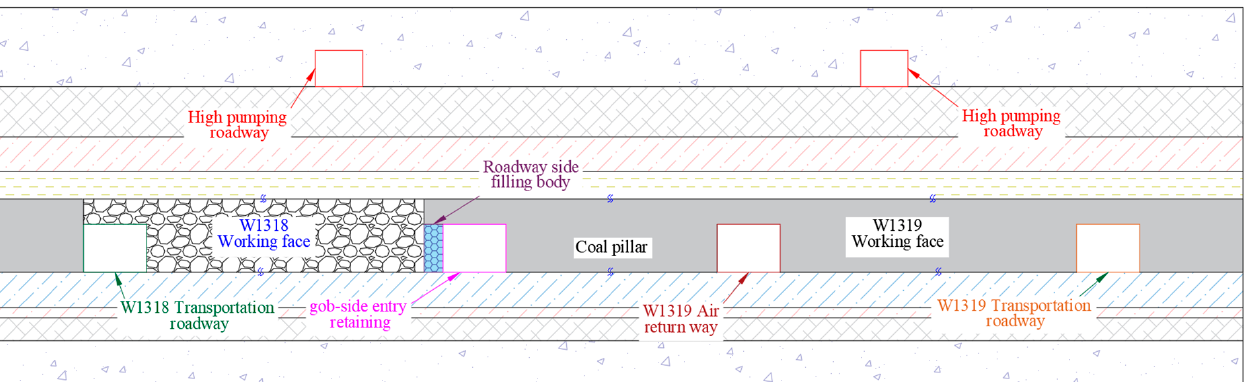
Figure 2. Layout of working faces and roadways.